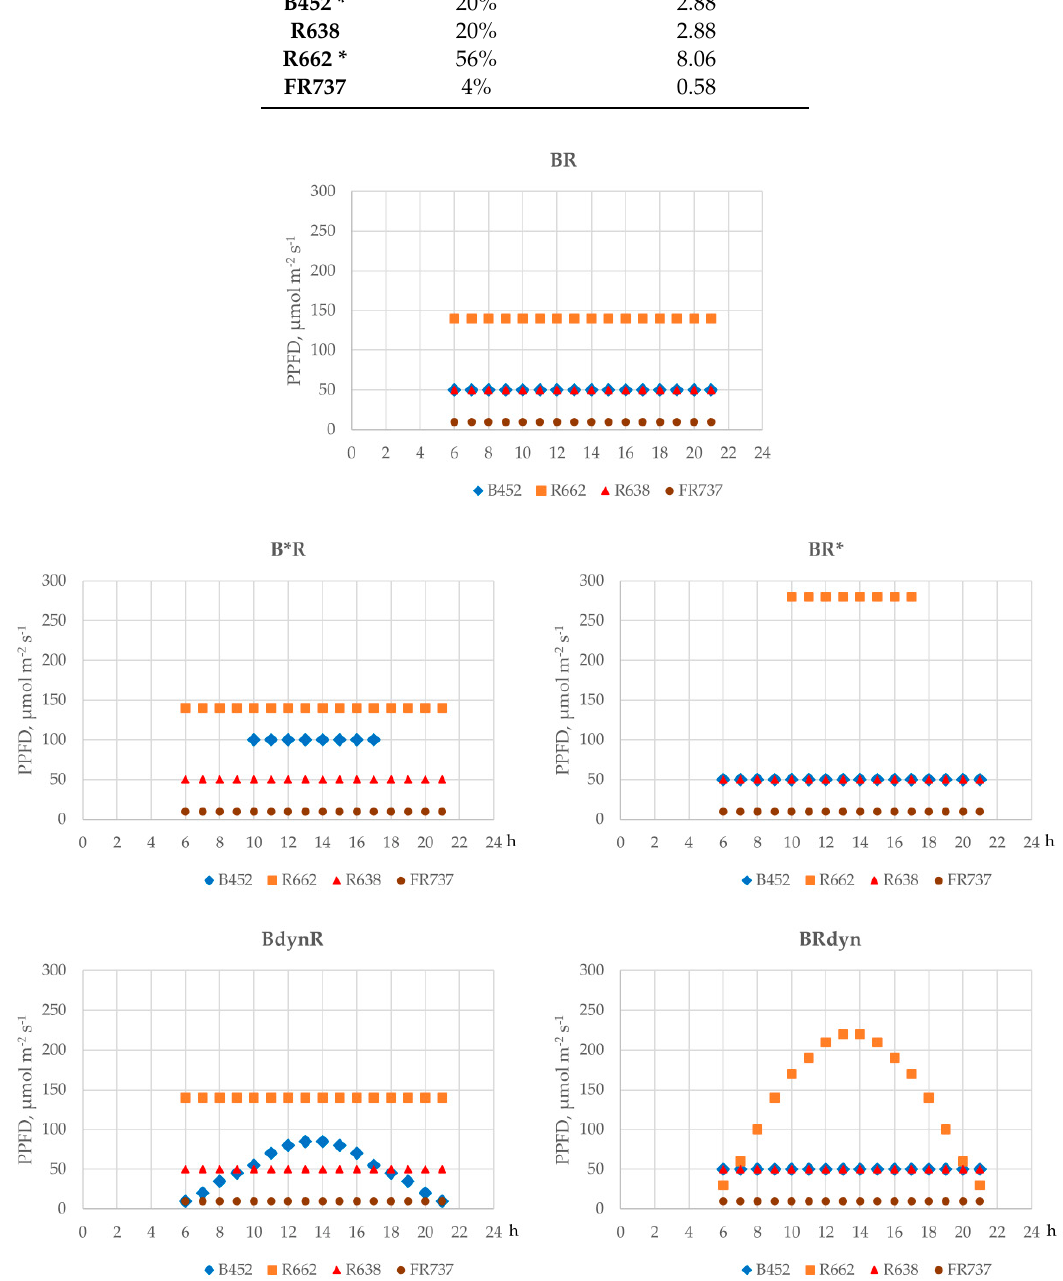
Figure 1. Distribution of the photosynthetic photon flux density (PPFD) of individual LED wavelengths during the photoperiod with each component’s equal DLI in different treatments.